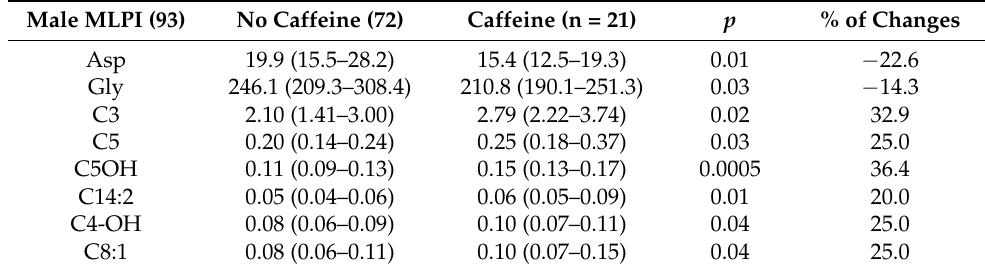
Figure 3. ( A ). Box plot of metabolites ( µ M) that displays the difference in VPI females not treated with caffeine ( n = 41; grey bars) and treated with caffeine ( n = 25; stripped bars). ( B ) . Box plot of amino acids ( µ M) that displays the sex difference in VPI males not treated with caffeine ( n = 52; white bars) and treated with caffeine ( n = 29; stripped bars). ( C ). Box plot of metabolites ( µ M) that displays the sex difference in females ( n = 41; grey stripped bars) and males ( n = 50; white stripped bars) treated with caffeine. ( D ). Box plot of metabolites ( µ M) that displays the sex difference in females ( n = 96; grey bars) and males ( n = 25; white bars) not treated with caffeine. The horizontal line across the box represents the median, and the box comprises the first and the third quartiles. The vertical lines represent the minimum and the maximum values. Red boxes represent an enlargement of the box plots necessary due to the different scale on the y axis. Table 4. Caffeine effect in male